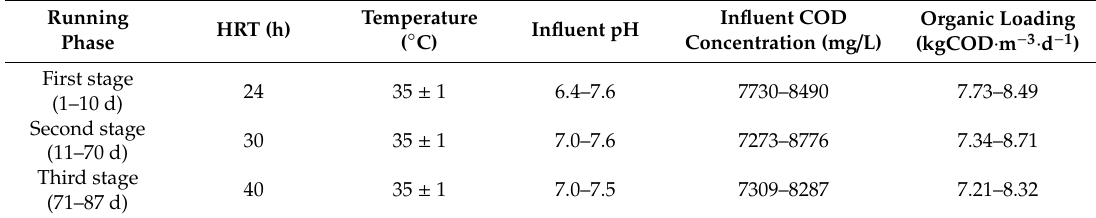
Figure 1. Schematic diagram of the experiment. Table 1. The parameters of an anaerobic baffled reactor (ABR).